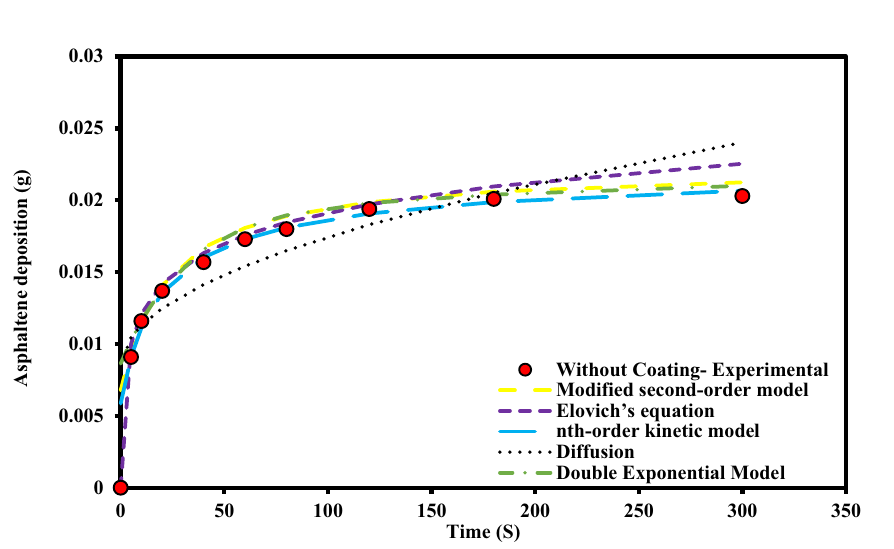
Figure 13. Comparison of experimental data and deposition kinetic models for uncoated electrode at 2000 ppm concentration in static